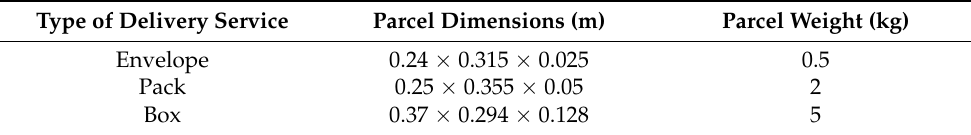
Table 3. Packages